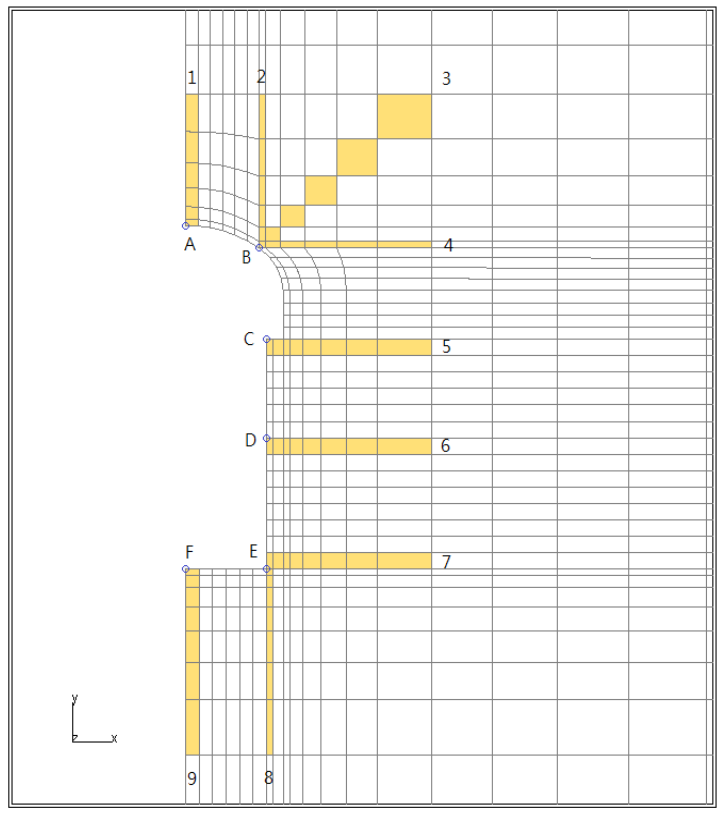
Figure 9 . 3D finite element model of the underground silo.